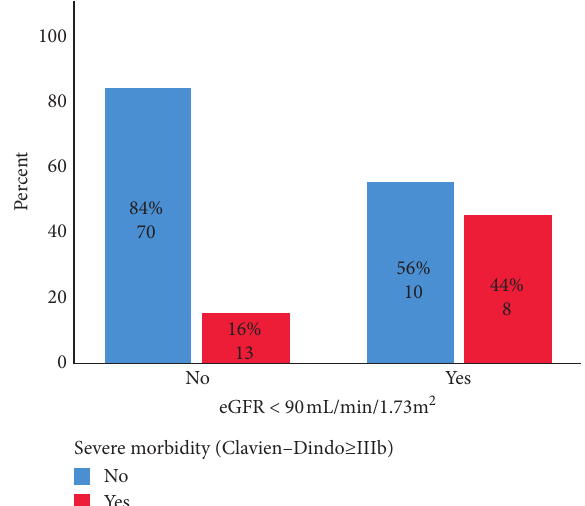
Figure 3: Severe morbidity (Clavien–Dindo ≥ IIIb) rate after PD grouped by having an eGFR < 90 mL/min/1.73m 2